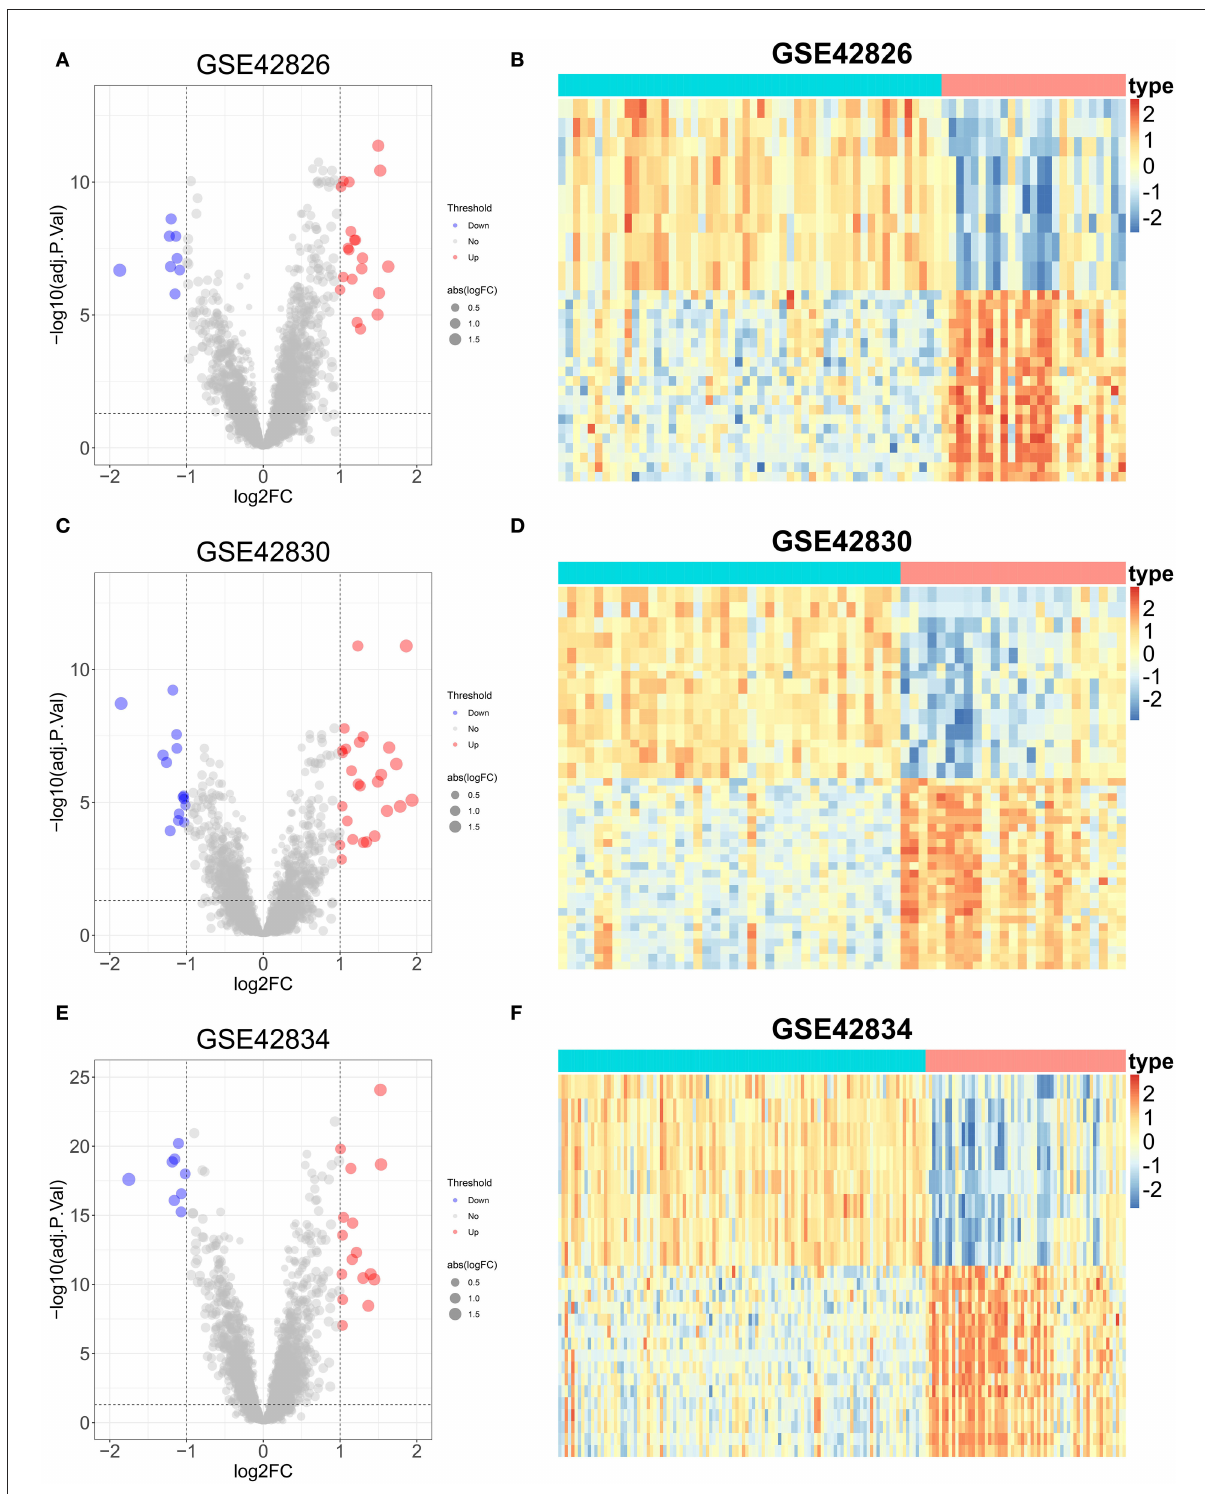
FIGURE4 Differential expression genes analysis of three sarcoidosis datasets. (A) The volcano plot of DEGs in GSE42826. (B) The heatmap of the top 50 DEGs in GSE42826. (C) The volcano plot of DEGs in GSE42830. (D) The heatmap of the top 50 DEGs in GSE42830. (E) The volcano plot of DEGs in GSE42834. (F) The heatmap of the top 50 DEGs in